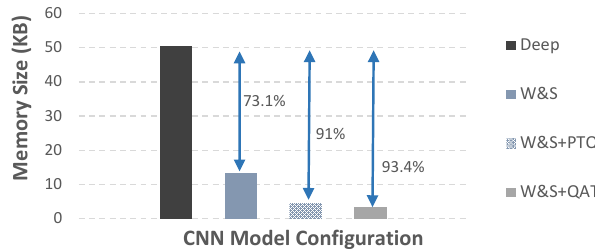
Figure 4. On-board memory footprint for different CNN